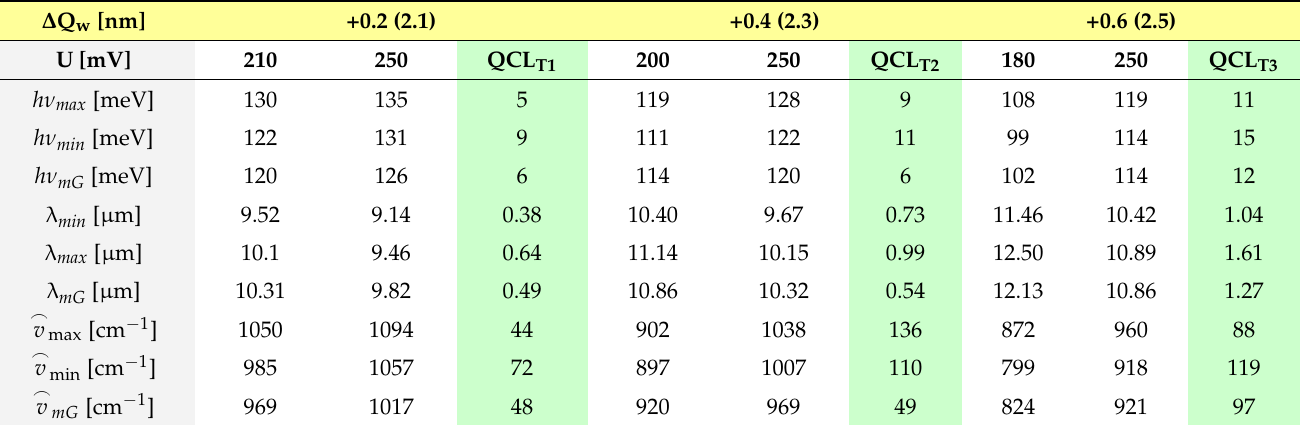
Table 3. Modeling the QCL tuning range by extending the size of the Q w